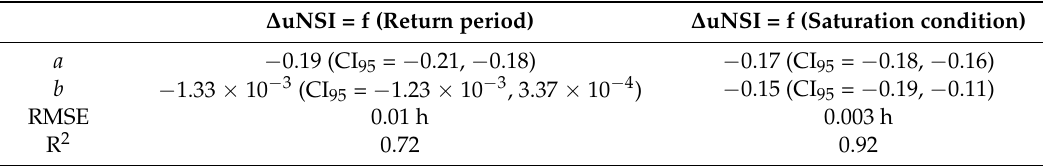
Table 4. Fitted coefficients, 95% confidence intervals (CI 95 ) and goodness of fit (R 2 and Root Mean Square Error—RMSE) for Equation (4) when considering the ∆ uNSI (difference between the network response in 2010 vs. 1983) as a function of the return period or as a function of the saturation condition.